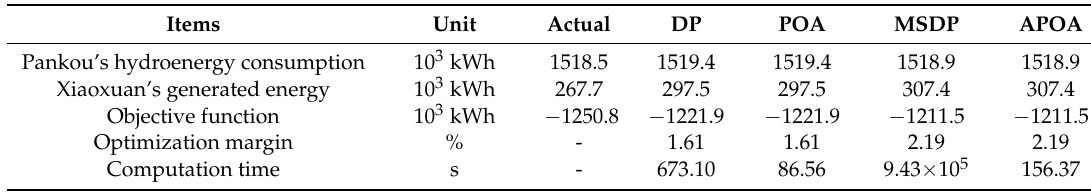
Table 4. The statistics of calculated results.